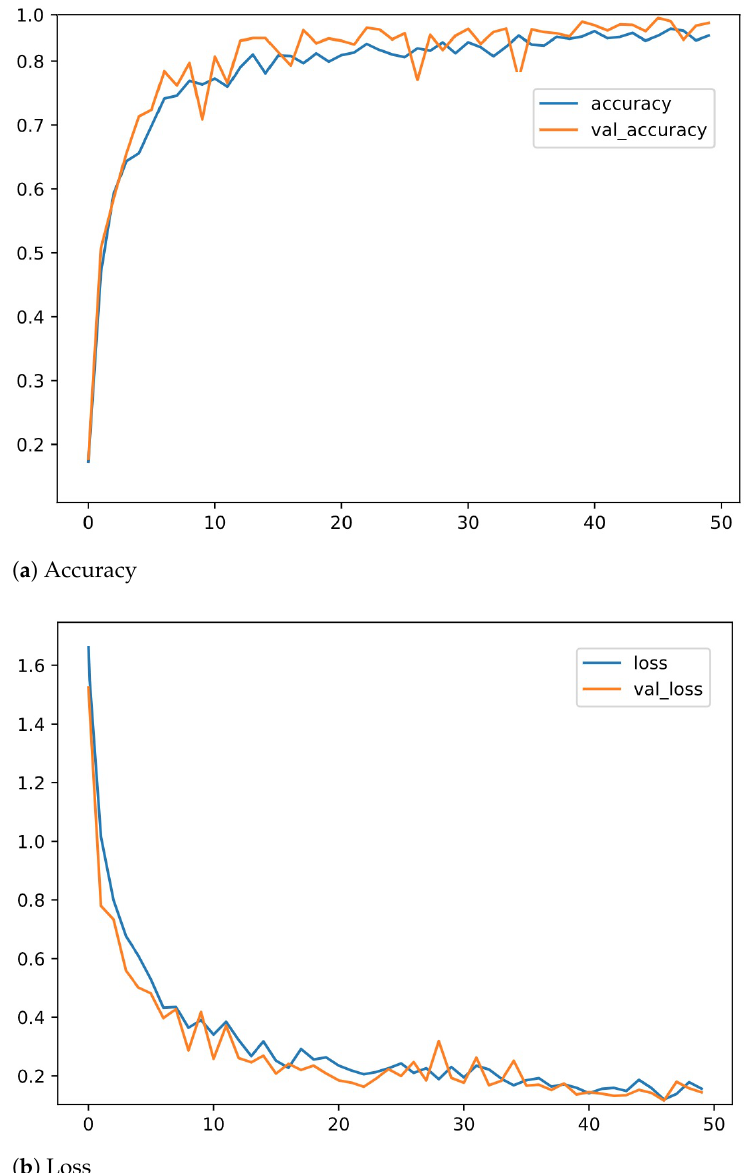
Figure 3. Accuracy and loss analyses of the proposed two-way feature extraction-based DNN on TESS